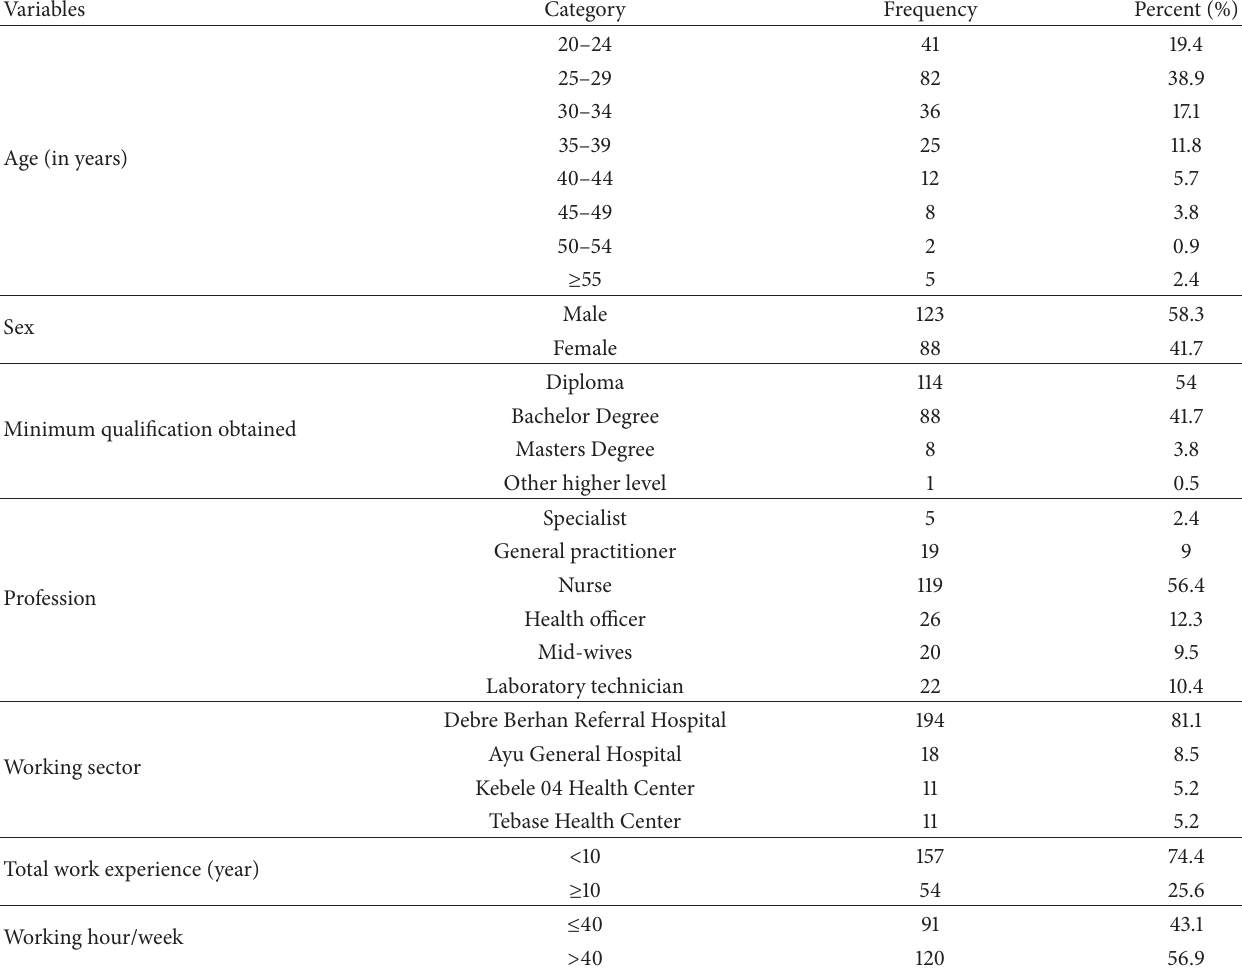
Table 1: Sociodemographic characteristics of the healthcare workers in Debre Berhan town,